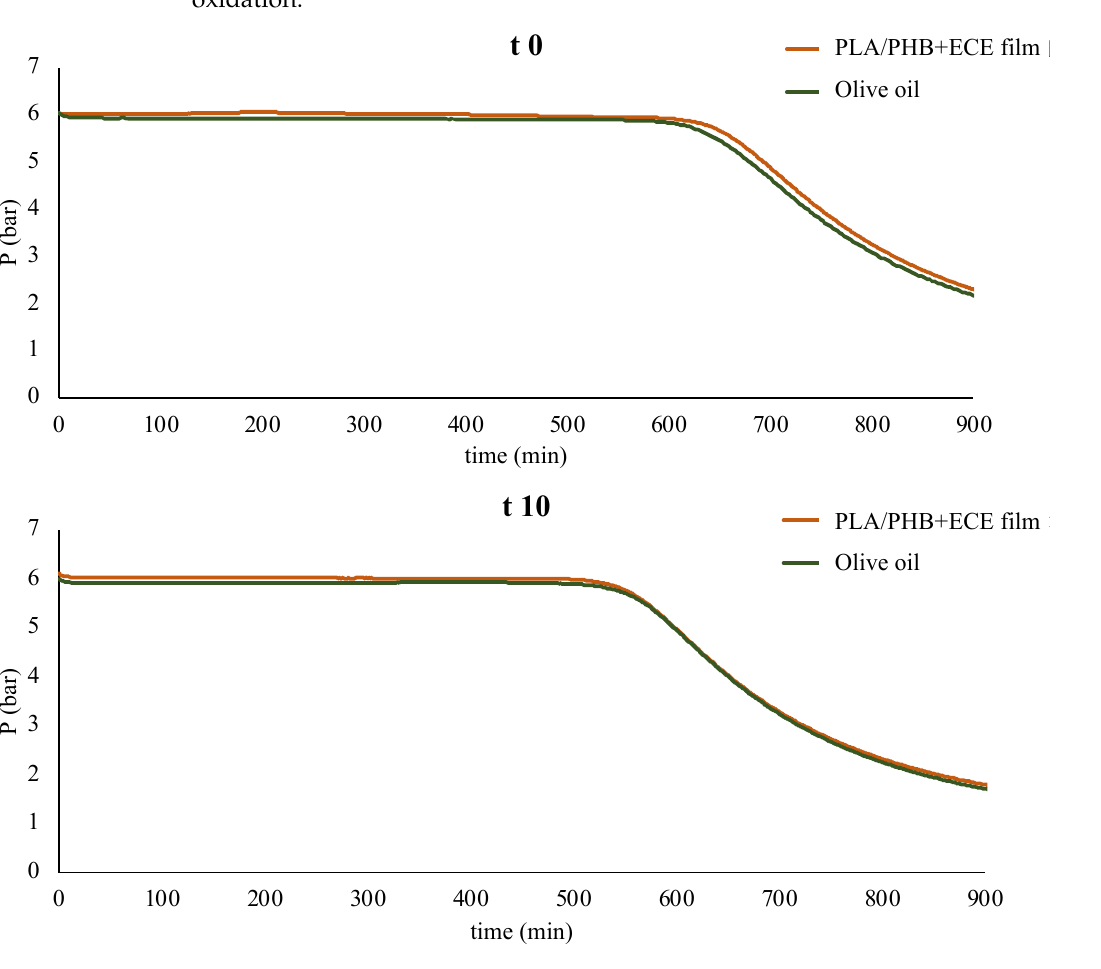
Figure 5. Oxitest analysis after 0 (t 0) and 10 (t 10) days of contact between the PLA/PHB+ECE film (orange) and the food simulant D2 (green).